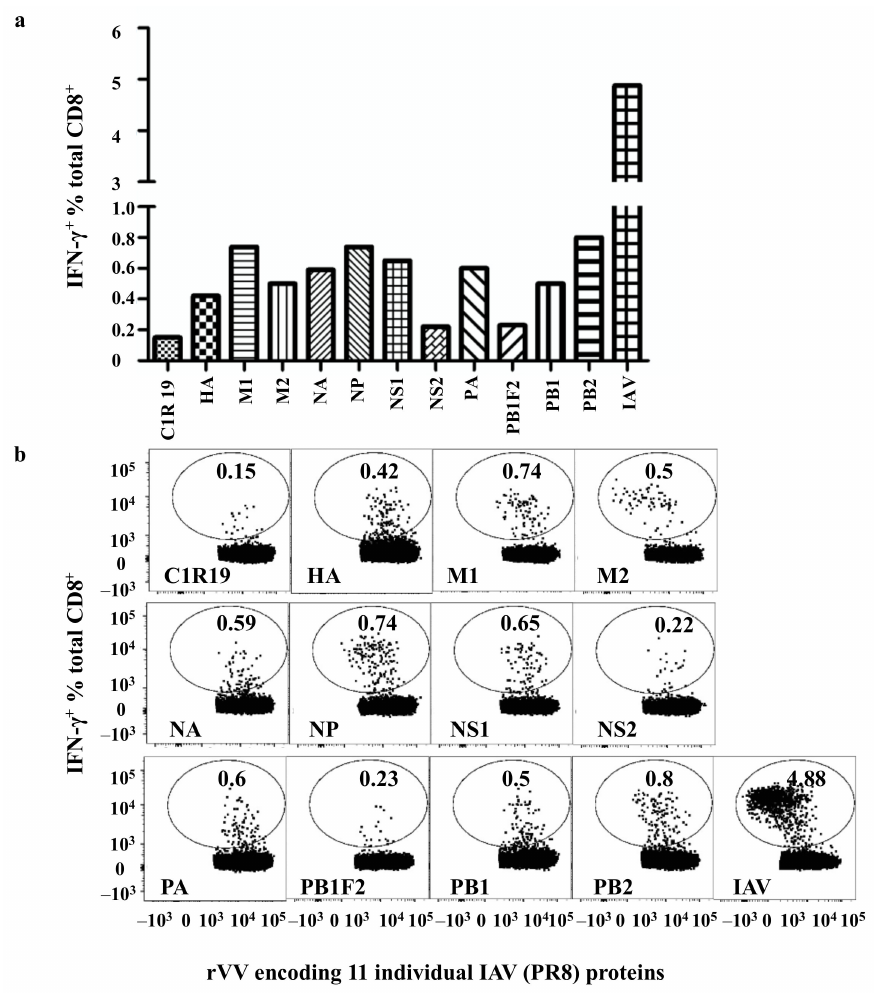
Figure 2. Broad-based CD8 + T cell responses to multiple IAV proteins. ( a ) Autologous BLCLs were infected with rVVs encoding individual IAV proteins for 16 hours before being used as APCs to assess CD8 + T cell responses via a standard ICS for IFN- γ production. ( b ) FACS profiles from this rVV